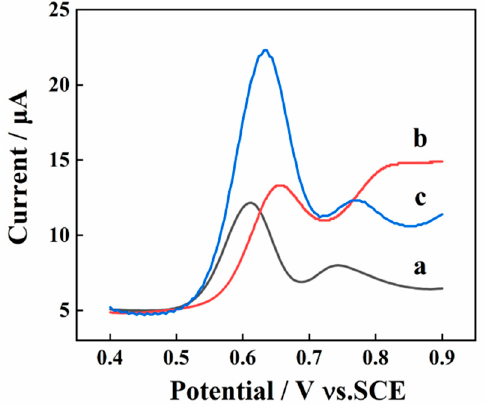
Figure 2. SWV curves of 10 μ M SY in 0.1M PBS (pH 7.0) on bare GCE (a) and AGCE (b); Accumula- tion potential: 0 mV; Accumulation time: 15 s.